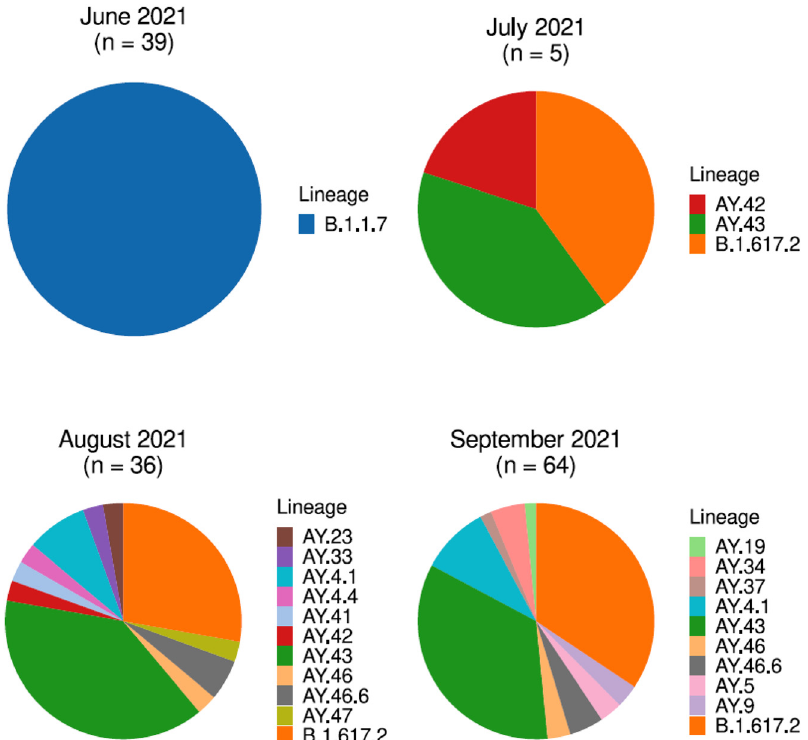
Figure 1: SARS-CoV-2 lineage